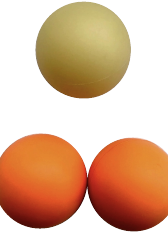
Figure 19: Lectures in hadronic chemistry are generally initiated by showing a ball in representation of a hydrogen atom with the recollection that quantum mechanics achieved an exact representation of all its experimental data. The speaker then shows two joined balls representing a hydrogen molecule, with the recollection that, this time, quantum mechanics and chemistry have not achieved an exact representation of molecular data. The reason indicated for this dichotomy is that mutual distances in the atomic structure, that are of the order of 10 − 8 cm , are such to allow an effective point-like approximation of the constituents. By contrast, mutual distances for valence electron pairs in molecular structures, which are of the order of 10 − 13 cm , are smaller than the size of the electron wavepackets, which is of about 2 . 2 × 10 − 13 cm , thus prohibiting an effective point-like approximation of particles in favor of the representation of their actual size and as well as of the ensuing contact non-potential interactions due to deep wave